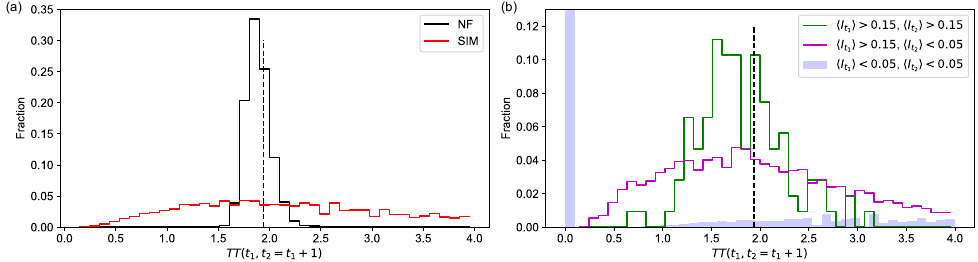
Figure 3. ( a , c ) The ROI-averaged intensity (cid:104) I t (cid:105) (photons/pixel) for each scaled speckle pattern in the time series, for the Gamma and exponential distributions, respectively. ( b , d ) The histograms of (cid:104) I t (cid:105) in ( a , c ) respectively. The time-averaged (cid:104) I t (cid:105) = 0.04 for both stacks of speckle patterns are shown by vertical lines. ( e ) The calculated g 2, SIM from data with frame-to-frame intensity variations in ( a , c ) are shown by colored symbols. The black dashed line is the g 2, NF .